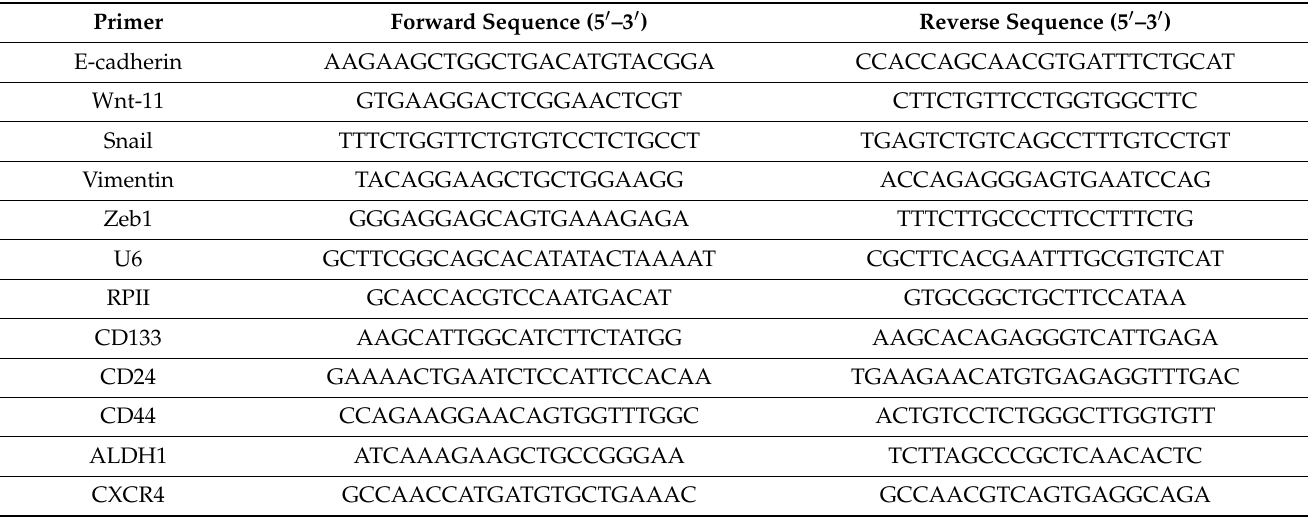
Table 2. Sequences of primers used in the